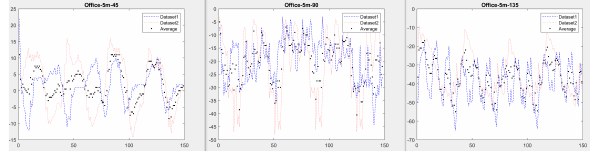
Figure 11 . Results of the tests in the office area.